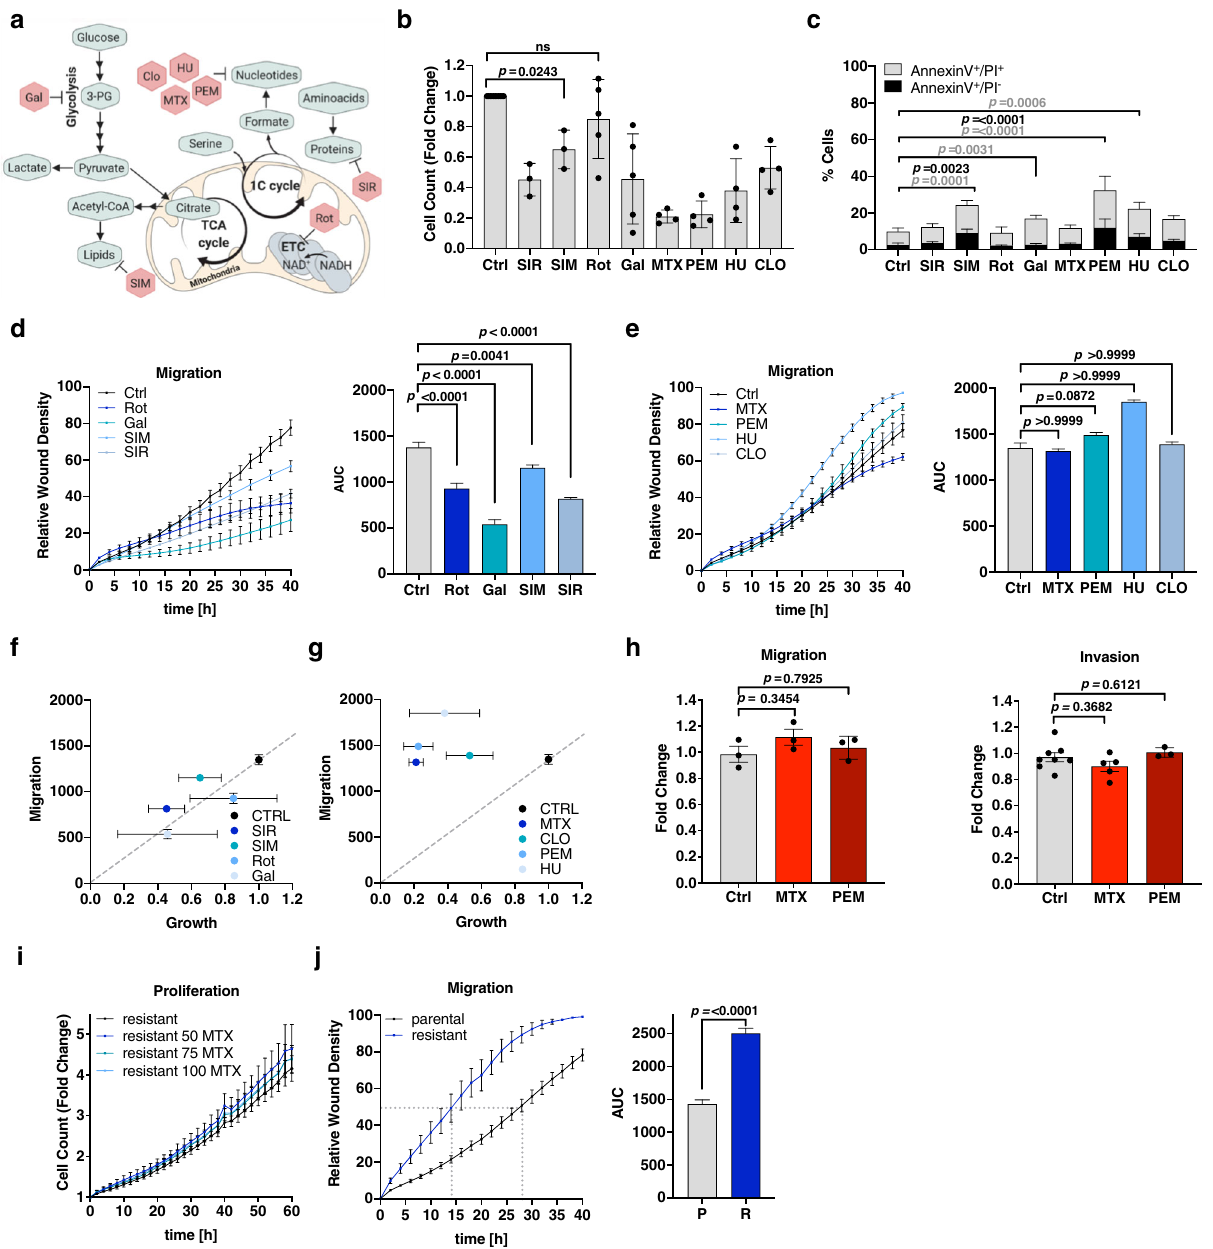
Fig. 1 Inhibition of major anabolic synthesis routes differentially impacts the motility potential of cancer cells. a Synthesis routes of metabolic building blocks (lipids, nucleotides, and proteins) and pharmacologic intervention points of the selected drug panel. b MDA-MB-468 cells were counted after 48 h treatment with 100 nM Sirolimus (SIR) ( n = 3), 1 μ M Simvastatin (SIM) ( n = 3), 50 nM Rotenone (Rot) ( n = 5), galactose (Gal) ( n = 5) supplementation, 50 nM Methotrexate (MTX) ( n = 4), 1 μ M Pemetrexed (PEM) ( n = 4), 0.5 mM hydroxyurea (HU) ( n = 4), and 100 nM Clofarabine (CLO) ( n = 4). Mean± SD; ordinary one-way ANOVA with Dunnett ’ s multiple comparisons test. Unlabeled comparisons to Ctrl are all signi fi cant with p < 0.0001. c MDA- MB-468 cells were treated as in ( b ). Cell death was assessed by fl ow cytometry and AnnexinV-FITC/PI-staining; mean ± SD of independent experiments